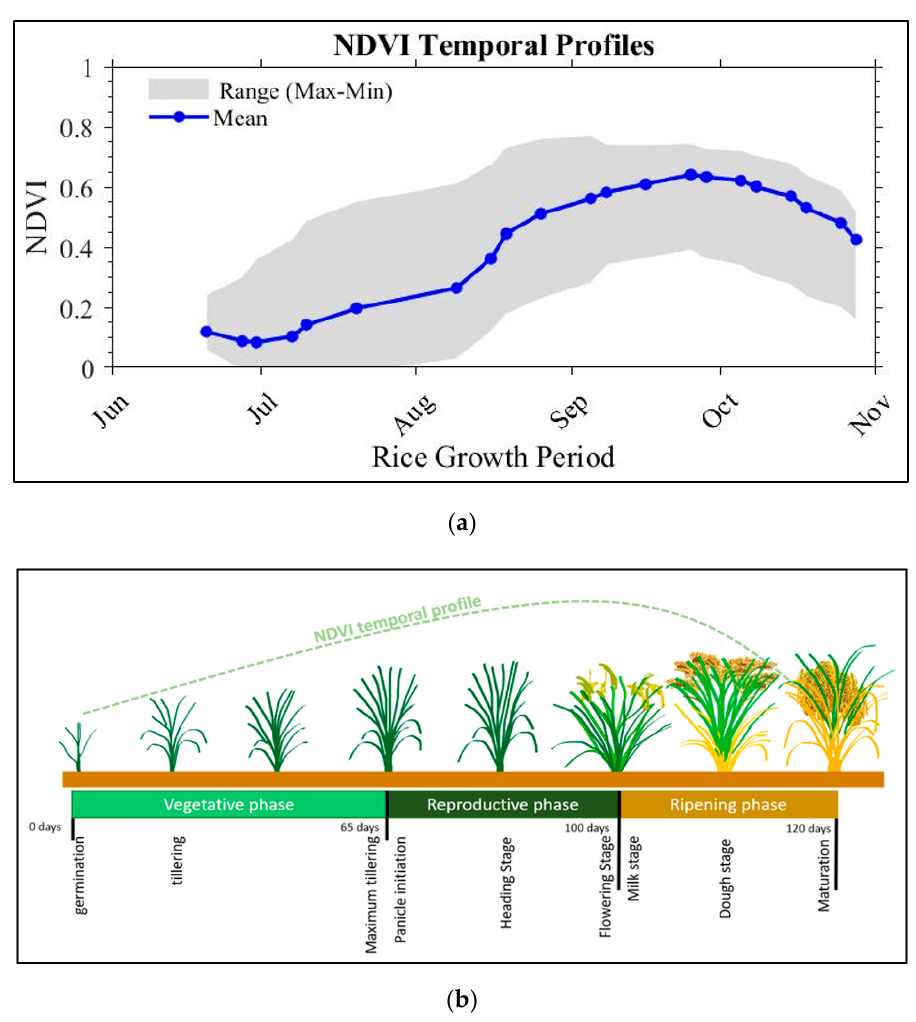
Figure 8. ( a ) The range and mean temporal profiles of Normalized Difference Vegetation Index (NDVI) spanning the entire growth period of rice crop. ( b ) The temporal profile of vegetation index (NDVI) is closely in-line with the findings of [47] (shown in plot “ b